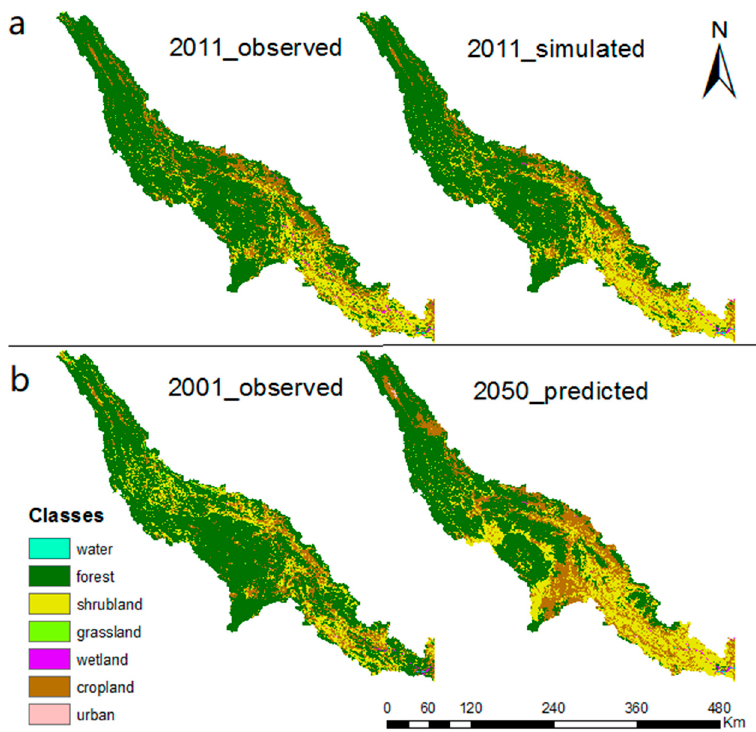
Figure 4. ( a ) Observed (left) and simulated (right) land cover maps of 2011; ( b ) Land cover maps of 2001(basin line) and 2050 (predicted). Table 3. Potential land cover change simulated by LCM in the Da River Basin (area percent: %). Table 2. Statistical parameters between the reference map and the simulated map of 2011. Land Cover Reference 2011 Land Cover (pix)